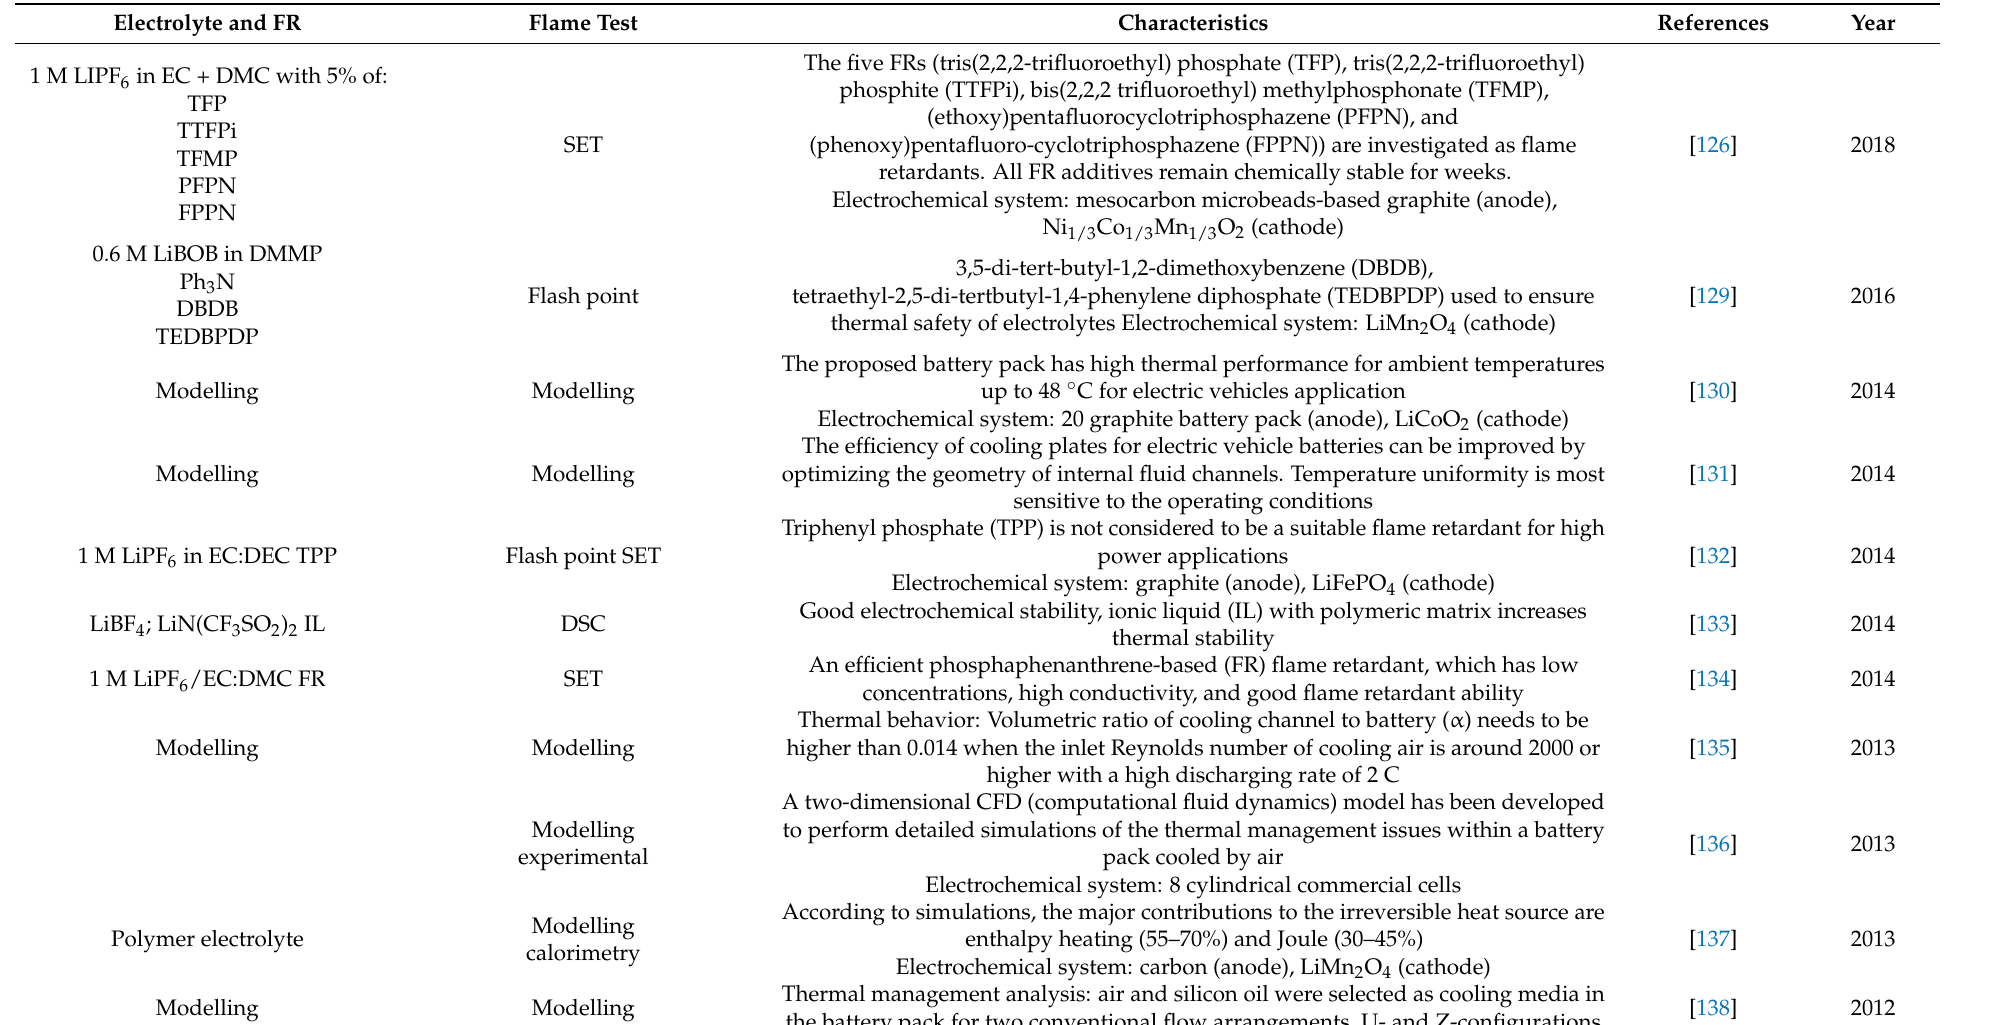
Table 8. Flammability of different electrolytes used for electrolytes in LIBs in the years 1998–2018. Electrolyte and FR Flame